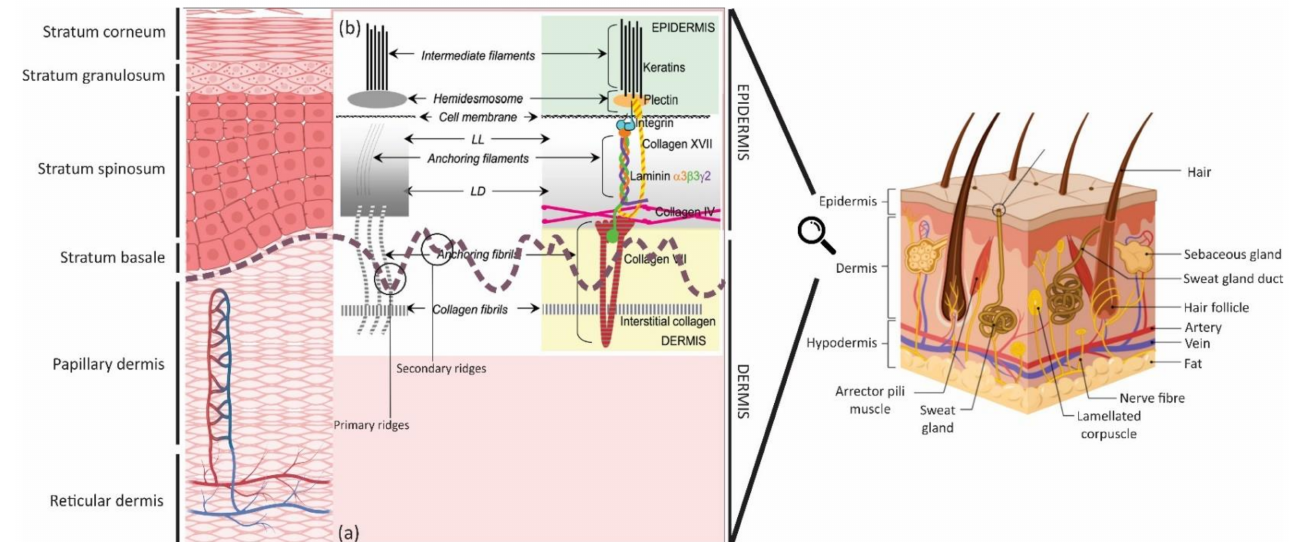
Figure 1. Skin schematic: ( a ) microstructure of the skin layers, magnifying the epidermis and dermis; created by Biorender and ( b ) DEJ representation. Schematic of different anatomical substructures, seen by transmission electron microscopy (the left diagram) (LL: lamina lucida and LD: lamina densa) and depicting the identified molecular components of substructures (the right diagram); reused with permission [30]—Reproduced by permission of The Royal Society of